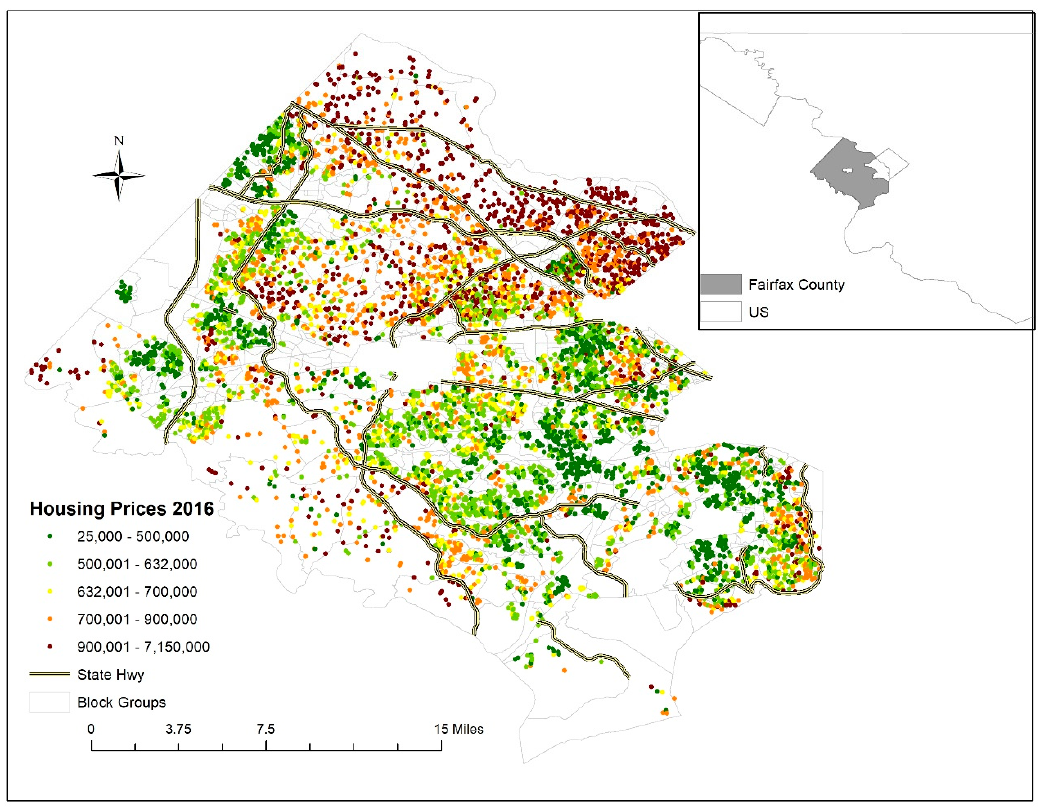
Figure 1. The geographic distributions of single-family house prices in 2016.